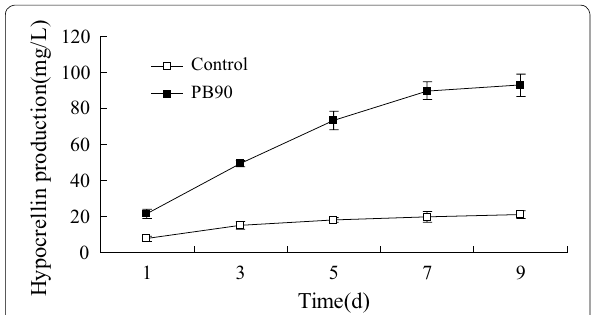
Fig. 1 Effects of PB90 on hypocrellin production. Tree-day-old cells treated with 5 nmol/L PB90 were harvested as the time indicated in the figure. The control received vehicle solvent only. The results shown are the average of five independent experiments.